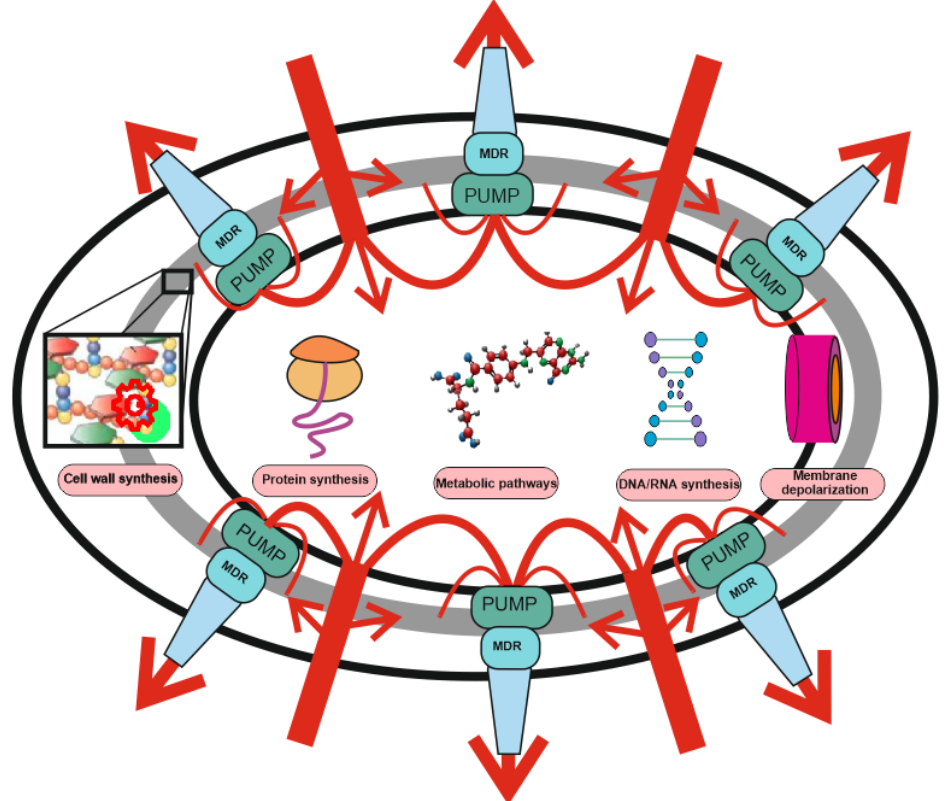
Figure 1. Two-level protection of bacteria from antibiotics: the role of MDR pumps in antibiotic resistance. Protection against antibiotics includes non-specific protection due to the operation of combination of MDR pumps with a wide range of substrate specificity (level 1), and specific protec- tion (level 2), including drug or target modification, drug inactivation, target switching and target sequestration. Antibiotic uptake (red arrows) is significantly weakened or stopped under the action of non-specific protection by means MDR pumps’ composition and only a small part of the drugs reaches the targets (protein synthesis, DNA/RNA synthesis, membrane depolarization, metabolic pathways, and cell wall synthesis). The efflux pump contribution may not be visible, but it can in- crease the MIC by several orders of magnitude. MDR pumps are involved in resistance to antibiotics with any mechanism of action and protect bacteria even against those antibiotics for which they do not have specific resistance